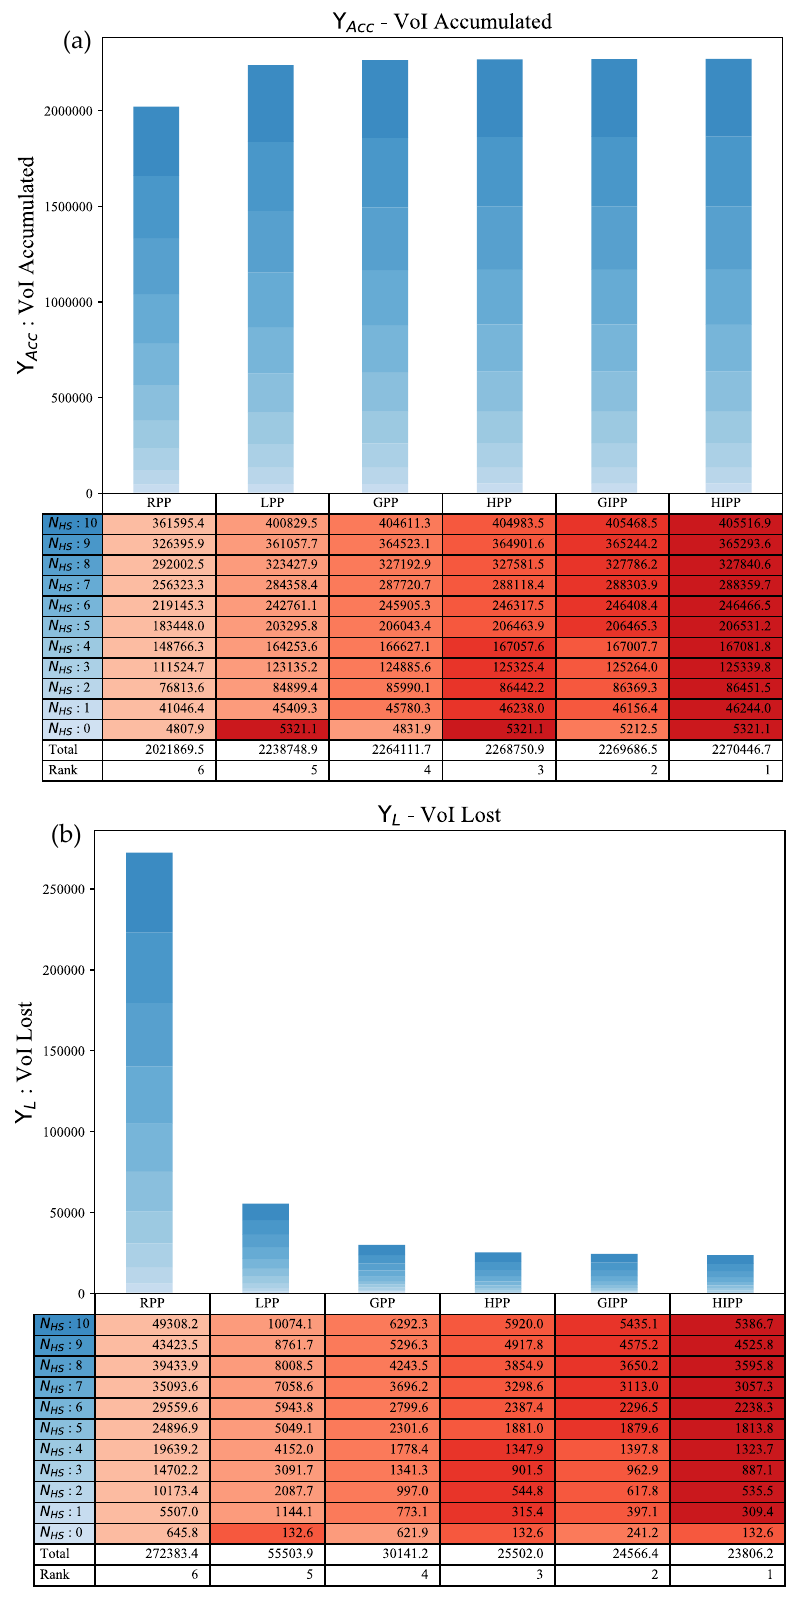
Figure 5. Comparative analysis for Υ ACC & Υ L : ( a ) The top stacked bar graph is for VoI accumulated Υ ACC ; ( b ) The bottom stacked bar graph is for VoI lost